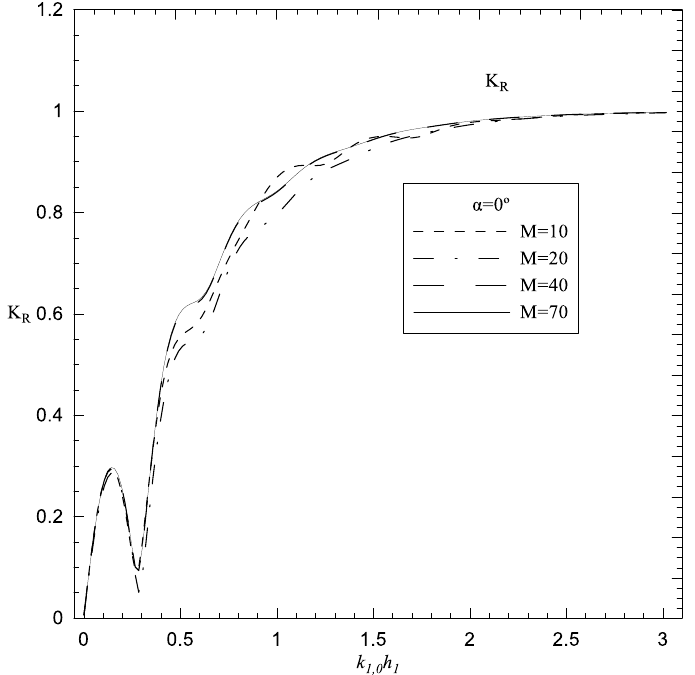
Figure 6. Convergence analysis of M for the water wave scattering by a rectangular structure behind a parabolic breakwater.